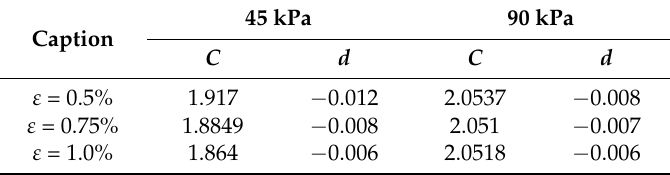
Table 6. Coefficients C and d of the Basquin proposition of the strain line in the S-N